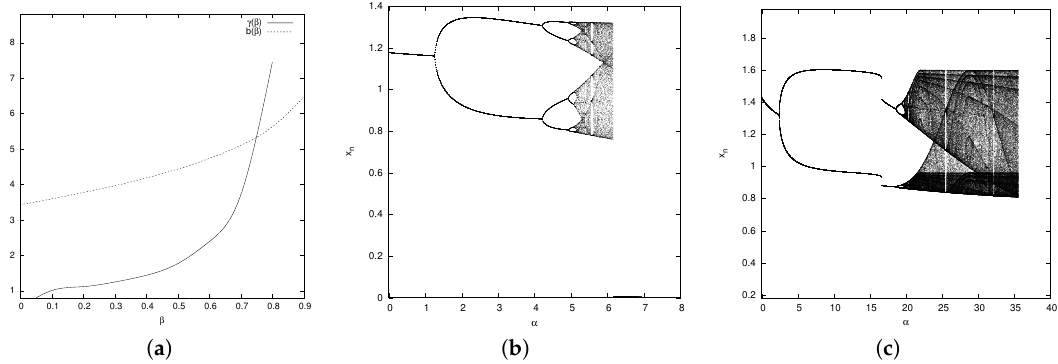
Figure 6. ( a ) Graph of b ( β ) . ( b ) Bifurcation diagram for β = 0.3. ( c ) Bifurcation diagram for β = 0.6.